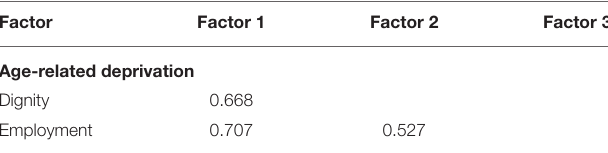
TABLE 4 | Discriminant validity assessment using HTMT